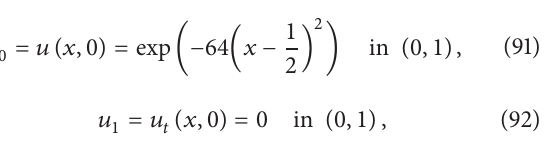
Figure 1: Solution shapes and contour lines with respect to 𝜅 = 10 and 𝜅 = 10 −0.3